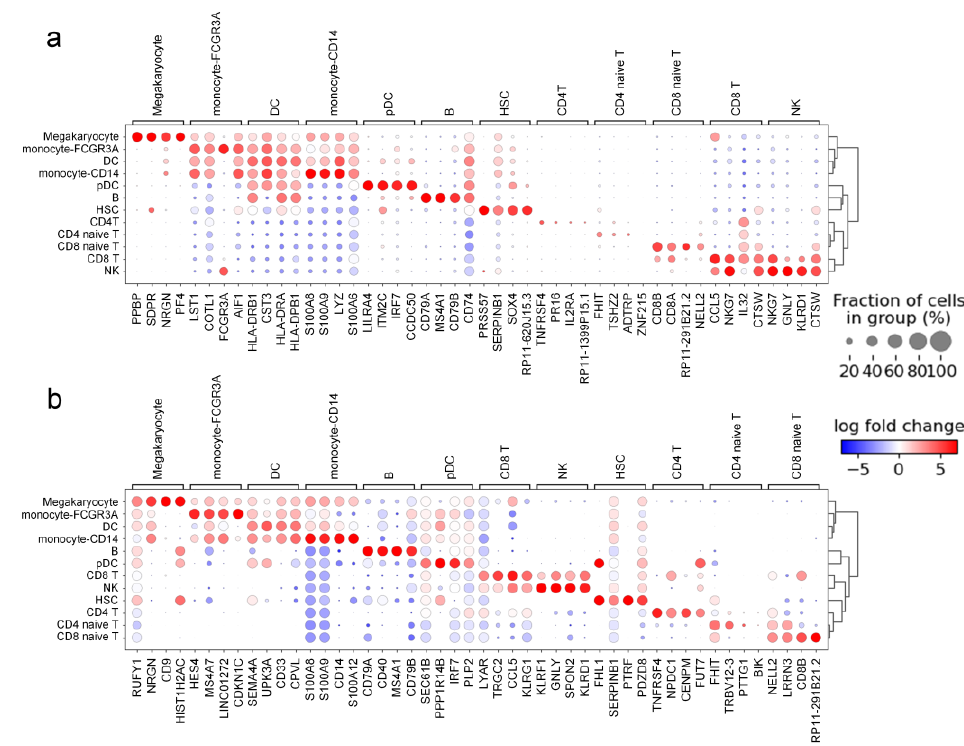
Figure 9. ( a ) Differentially expressed genes in the PBMC dataset before correction ( b ) Differentially expressed genes in the PBMC dataset after IMAAE correction.